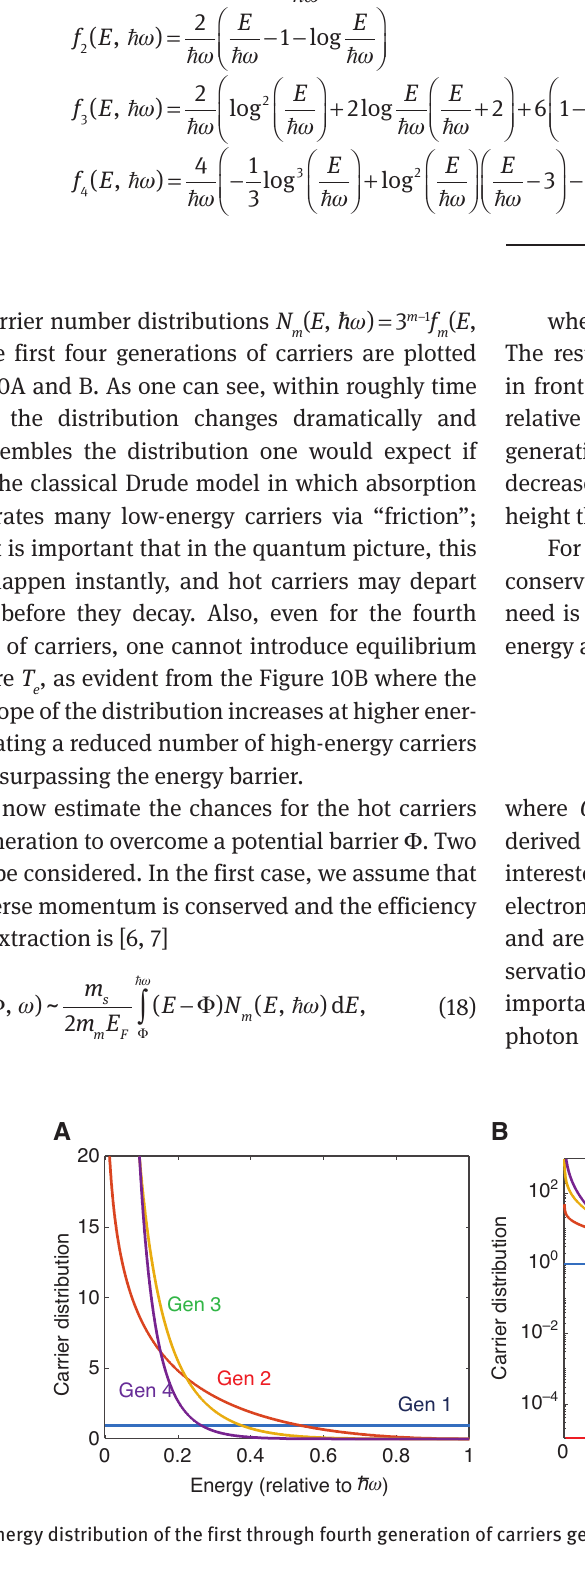
Figure 10: Energy distribution of the first through fourth generation of carriers generated as a result of decay of a single SPP with energy ħ ω